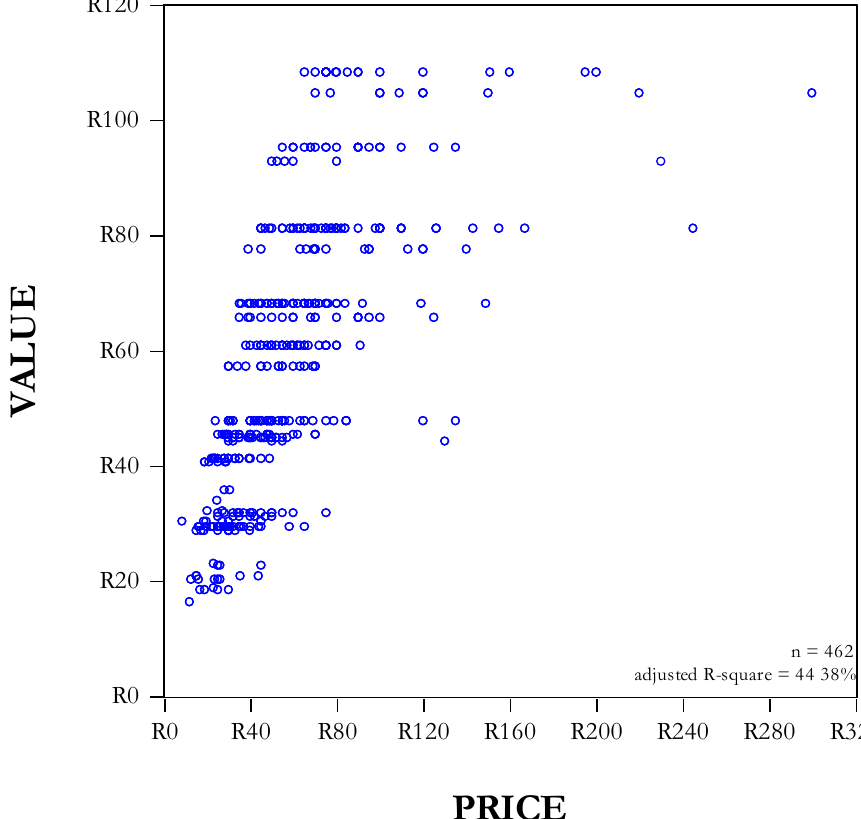
Figure 2: White wines 2007: price versus value: based on sighted tastings. This scattergram is derived from Table 3’s sighted model. Such tastings contain brand-cue bias and are thus invoked as predictors of brand (as opposed to generic)